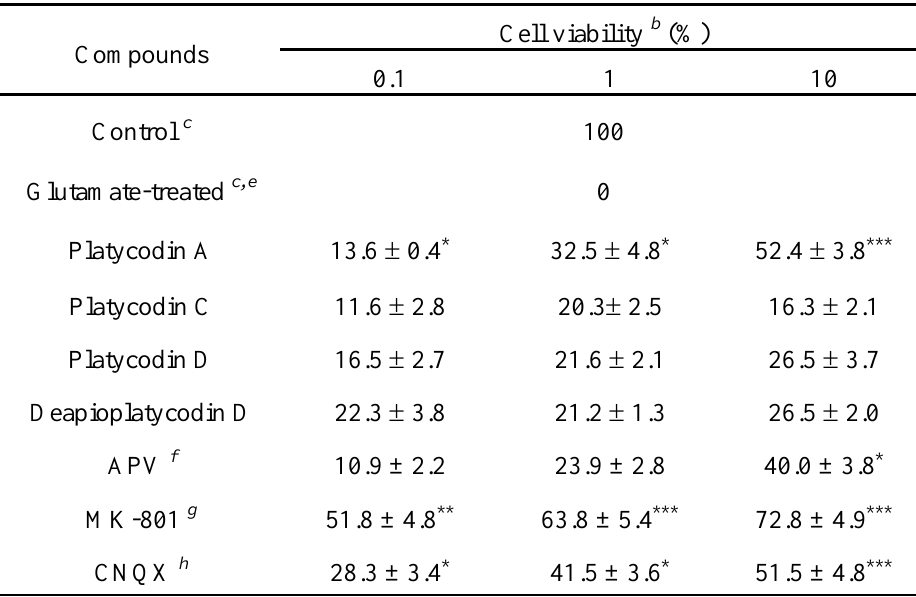
Table 1 . Neuroprotective effects of 4 triterpene saponin from P. radix against glutamate- induced toxicity in primary cultured rat cortical cells a